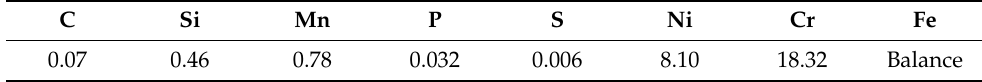
Table 1. Chemical composition of 304 stainless steel sheet (mass fraction, %).